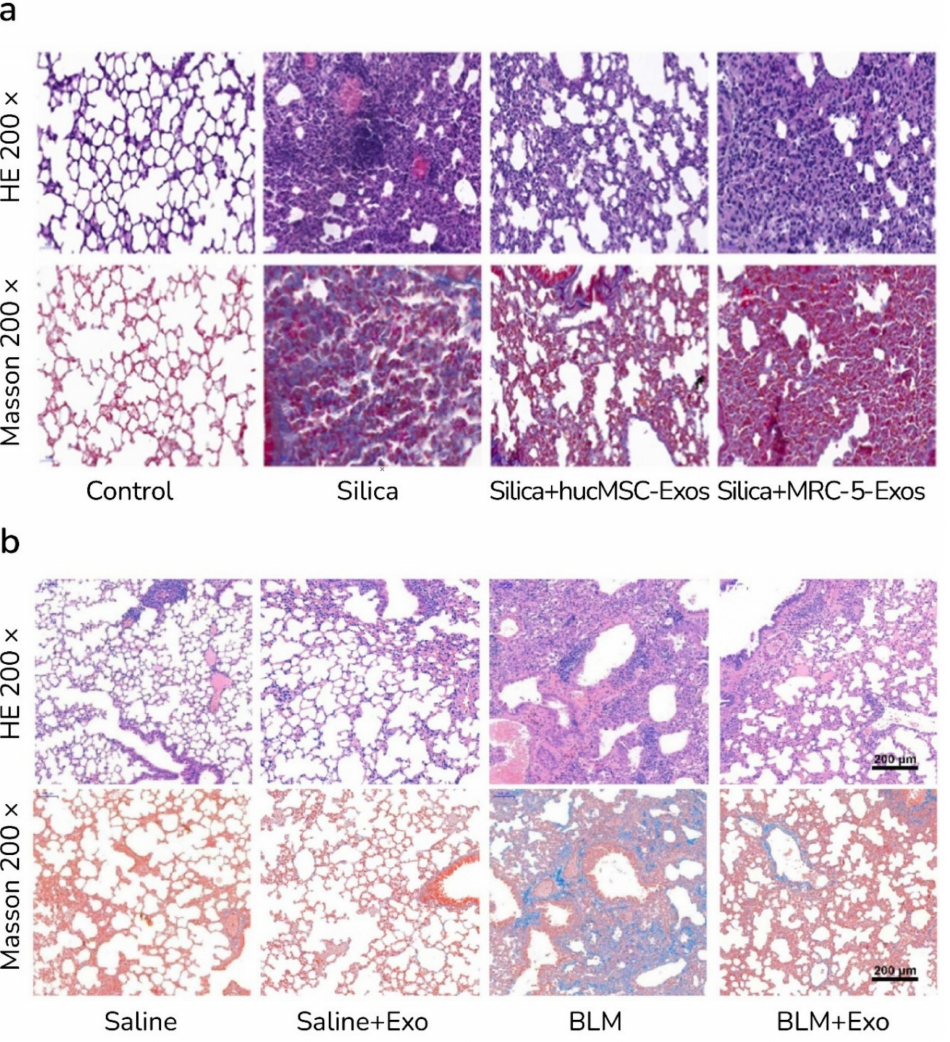
Figure 3. Effects of SC-Exos on PF in mice. ( a ) Human UCMSC-derived exosomes (hucMSC-Exos) but not MRC-5-Exos alleviated silica-induced mice model of pulmonary fibrosis (PF) (H&E and Masson staining; magnifications of 200 × via light micrograph [75]. ( b ) Menstrual blood-derived SC-derived exos showed protective effects in bleomycin (BLM)-induced PF in mice (H&E and Masson staining; the scale bar represents 200 µ m)